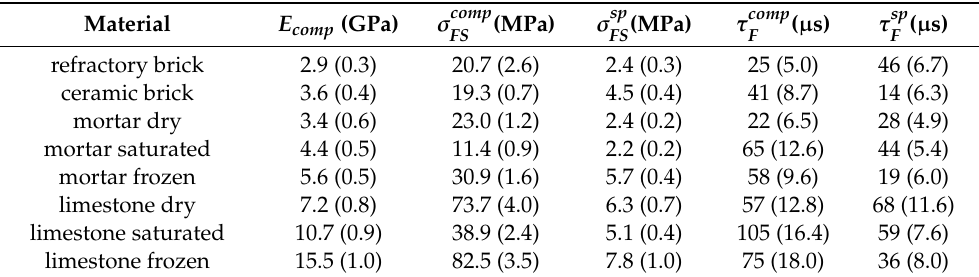
Table 1. Parameters of quasi-brittle materials: σ comp the quasi-static splitting strength; τ comp